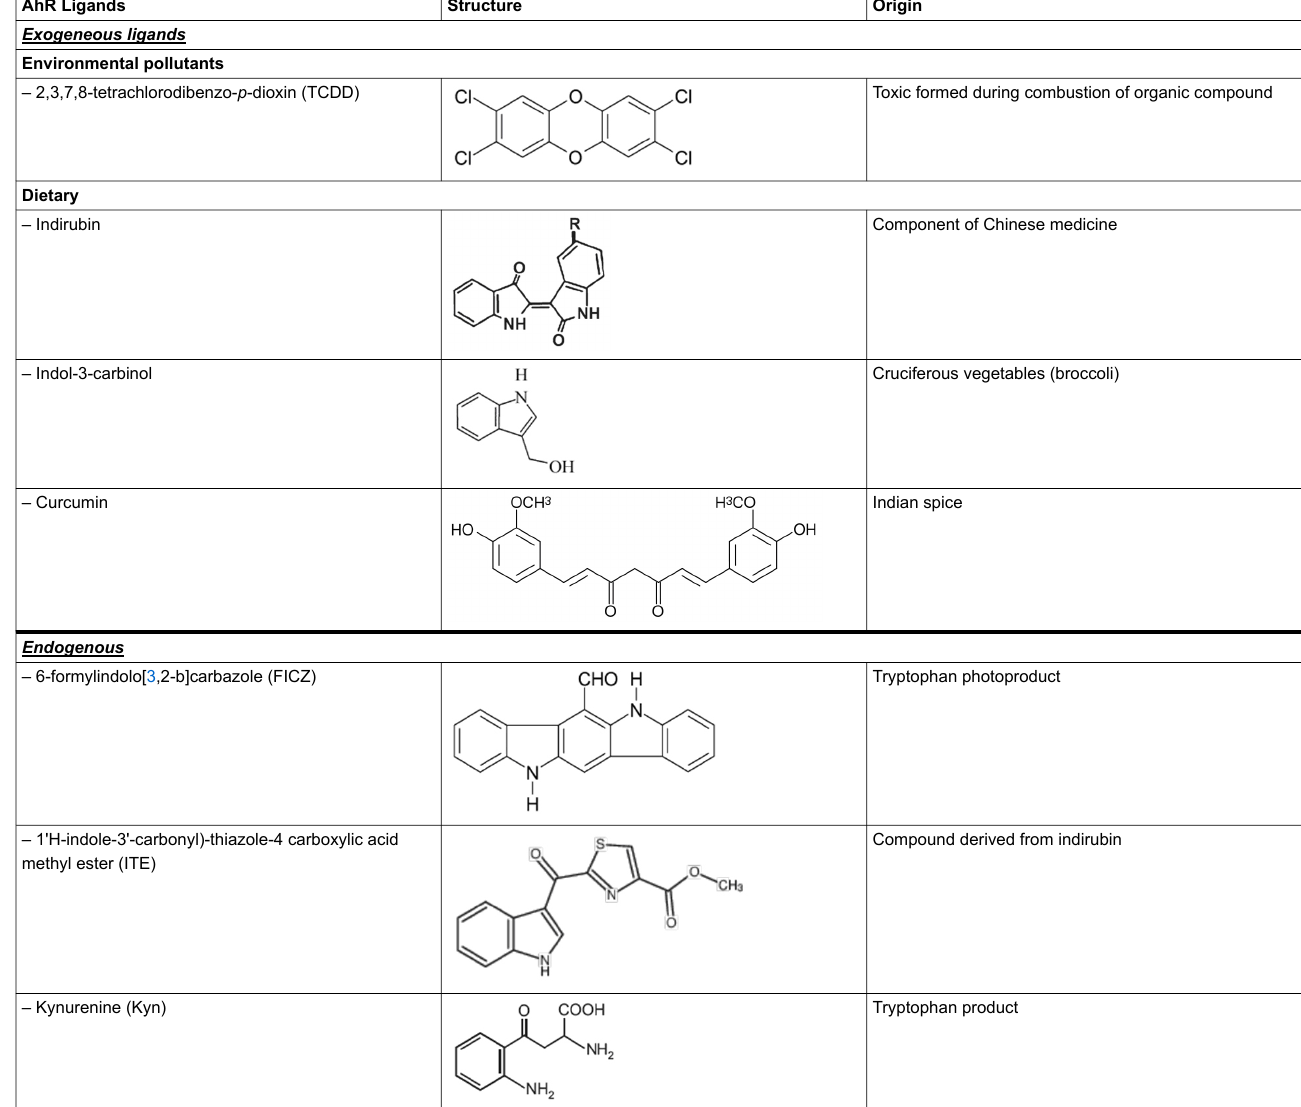
Table 2: AhR ligands. Structures and origins of exogeneous, environmental pollutants and dietary, and endogeneous AhR ligands discussed in this review. AhR